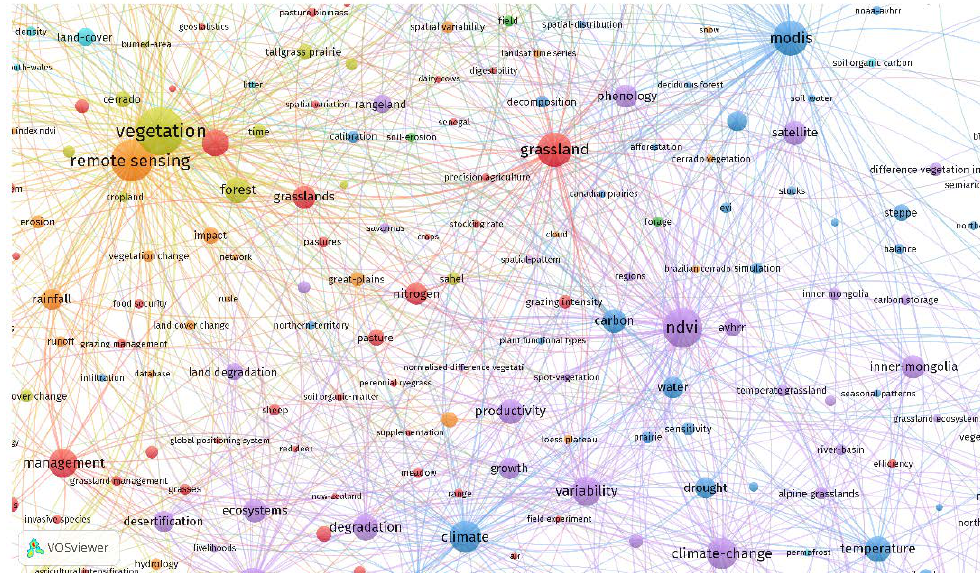
Figure A3. Links of the “NDVI” keyword zoomed-in Figure 6 from 1980 to 2020.